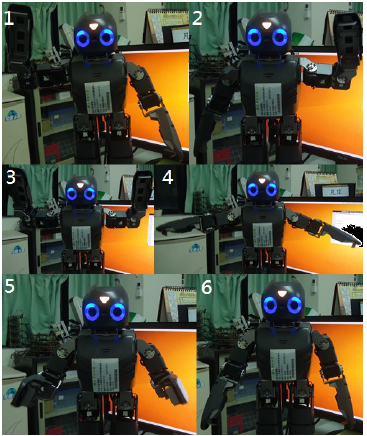
Figure 14. The humanoid robot is replaying action